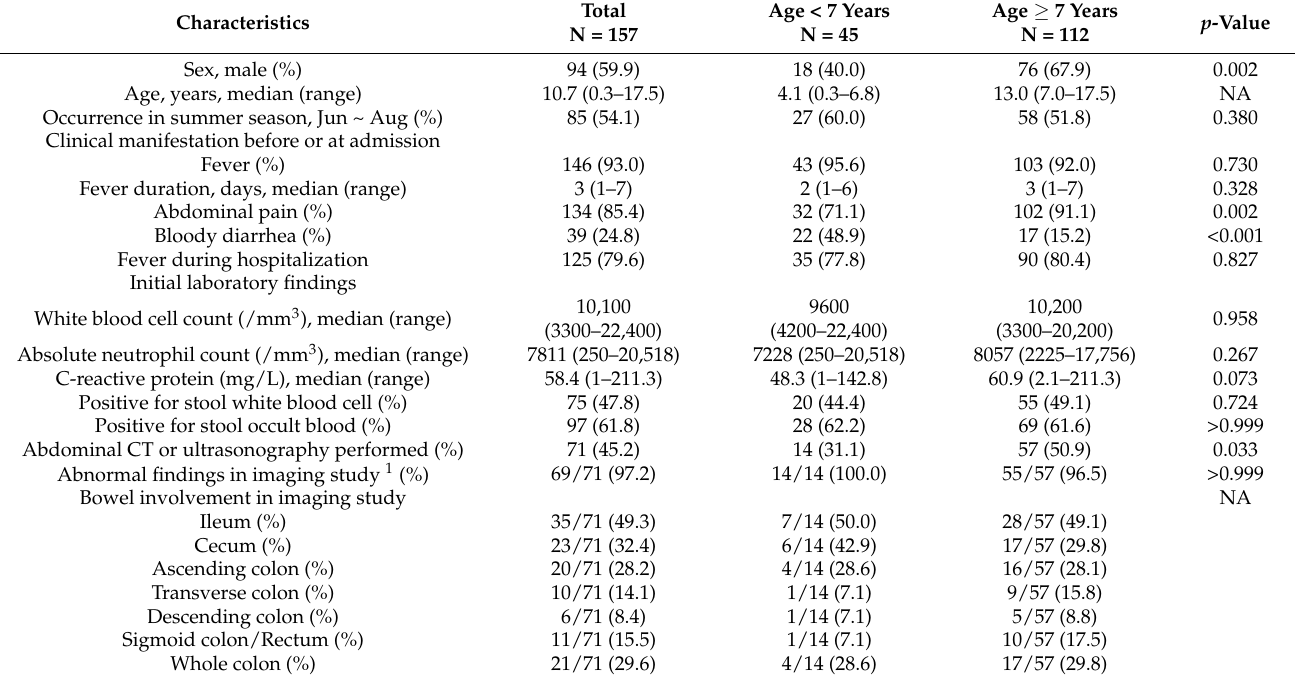
Table 1. Characteristics of the study